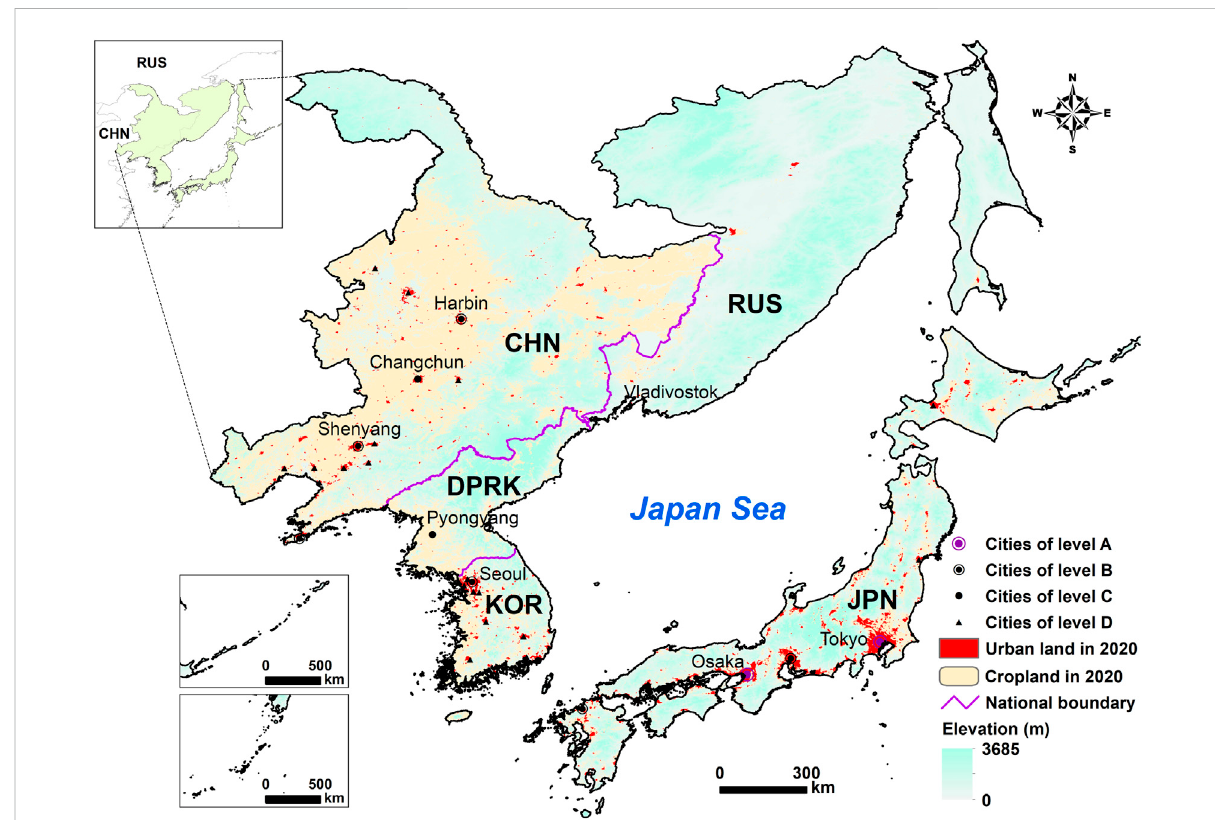
FIGURE 1 The study area. Notes: Cities of level A, B, C, and D refer to different kinds of cities. Cities of level A refer to the kind of city, for which urban populationsexceeding 10million. CitiesoflevelBrefertothecitieswithurbanpopulationbetween10and5million.Inaddition, citiesoflevelCrefer to the kind of city, for which urban populations between 5 and 3 million. Cities of level D refer to the kind of city with the smallest population, for which the urban population below 3